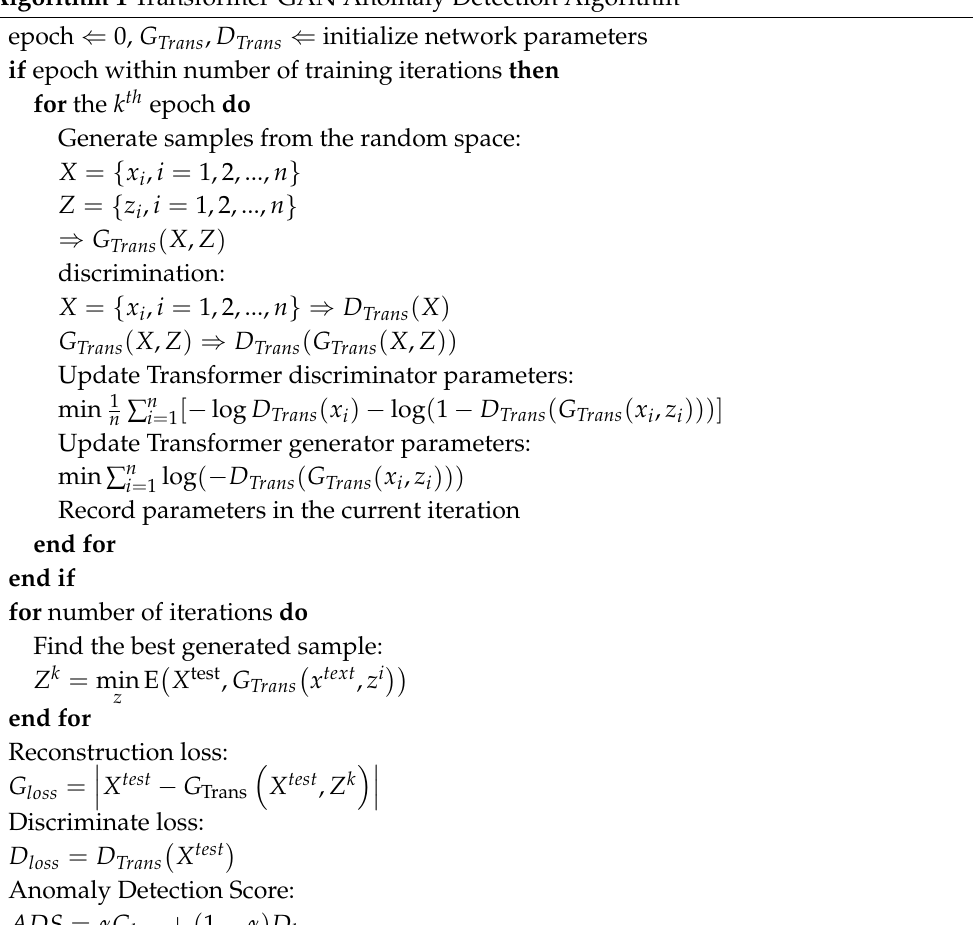
Algorithm 1 Transformer-GAN Anomaly Detection